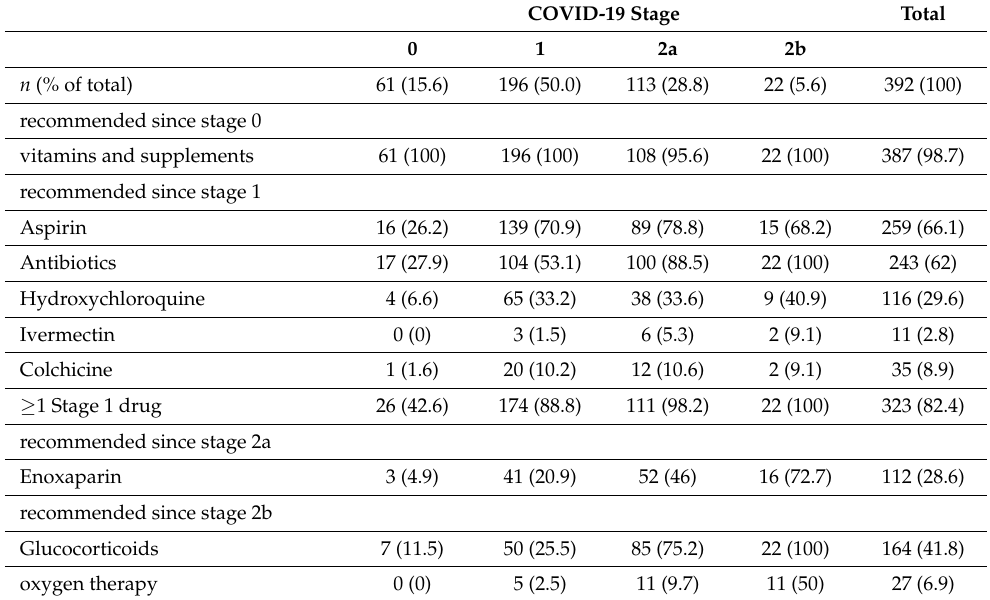
Table 2. Drugs prescribed throughout the treatment according to COVID-19 stage when patients were taken care of. Patients who were prescribed each drug or drug category are reported as absolute numbers and as percentage (in parentheses) of total patients in each COVID-19